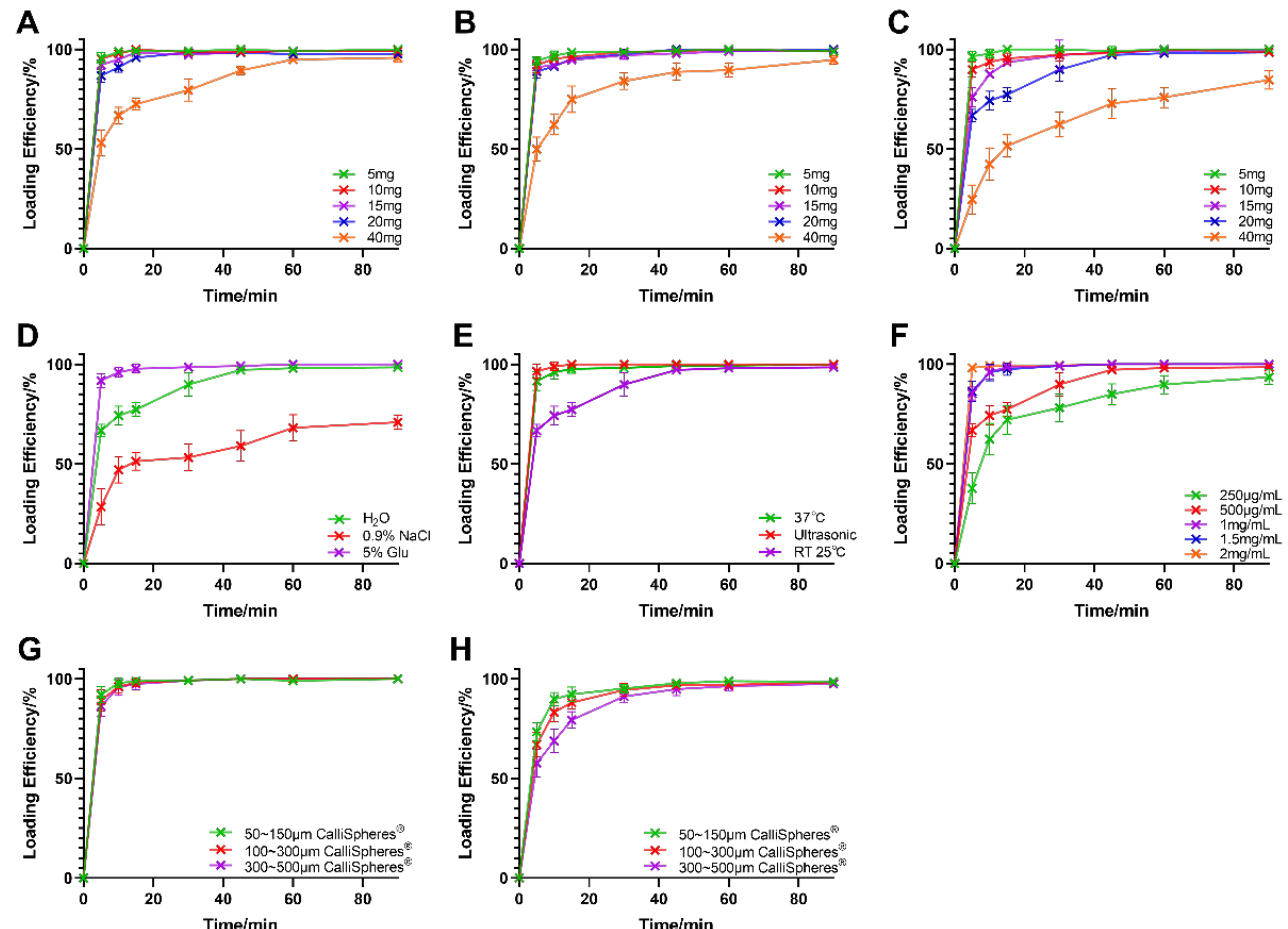
Figure 1. IDA loading efficiency with different loading methods ( n = 3). The results of screening the amount of drug to add in three CalliSpheres ® of different particle sizes: ( A ) 50–150 µ m; ( B ) 100–300 µ m; and ( C ) 300–500 µ m. The results of further loading method screening: ( D ) loading medium; ( E ) loading condition; and ( F ) drug concentration. The IDA loading curves by the optimized loading method are shown ( G ). The results of ultimate loading test are shown ( H ).